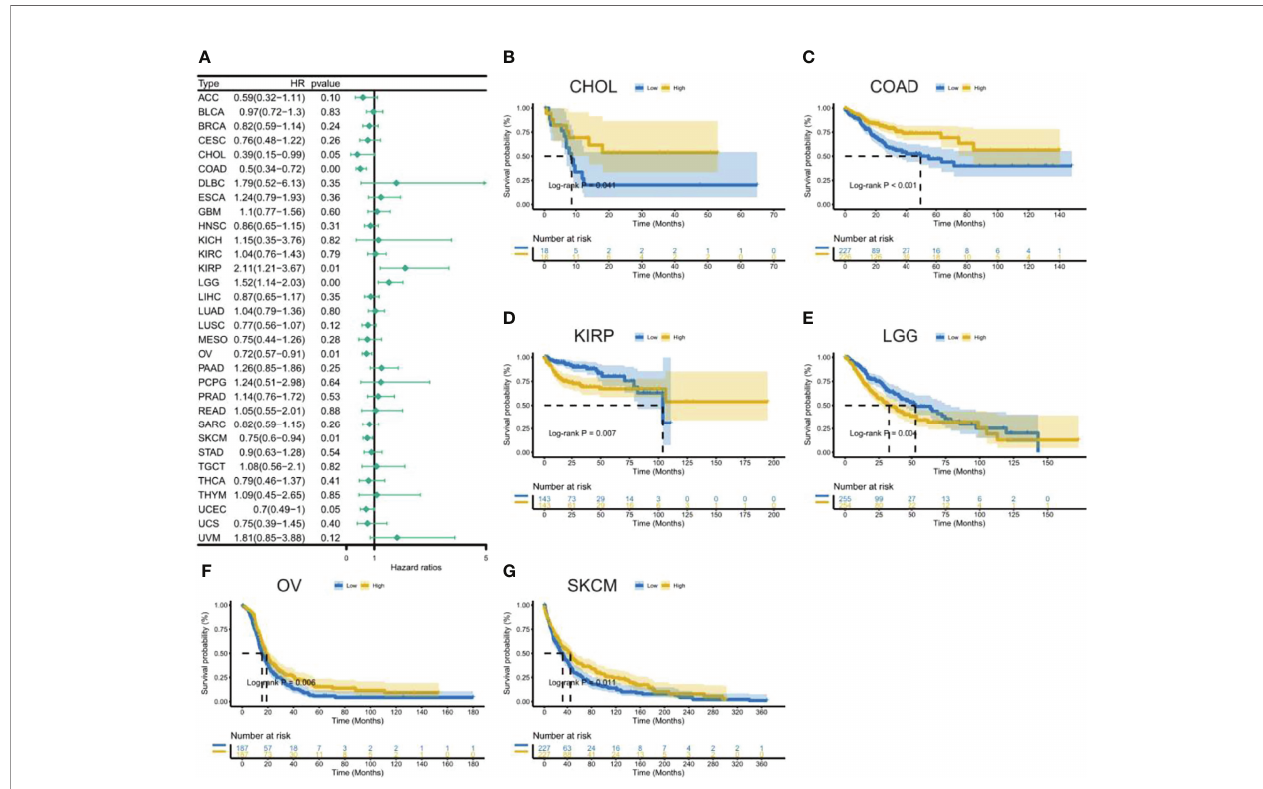
FIGURE 6 | Association between CXCL11 expression and disease-free interval (PFI). (A) Forest plot of DFI association with CXCL11 expression across cancers. (B – G) Kaplan – Meier analysis of the association between CXCL11 expression and DFI in CHOL, COAD, KIRP, LGG, OV, and